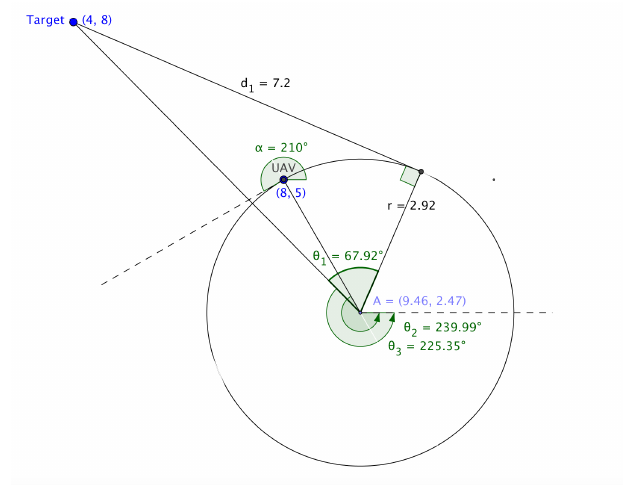
Figure 5. Calculating θ ’s based on Manathara et